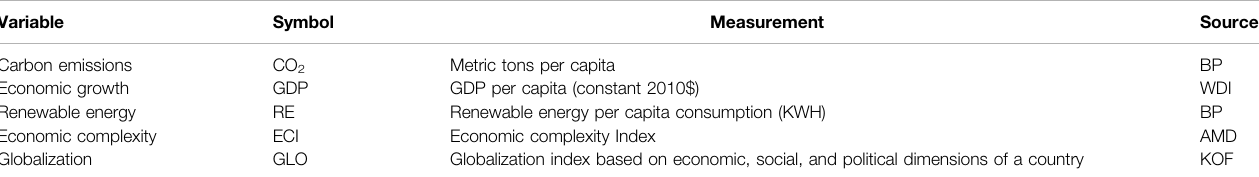
TABLE 1 | Variables, data source, and measurement.